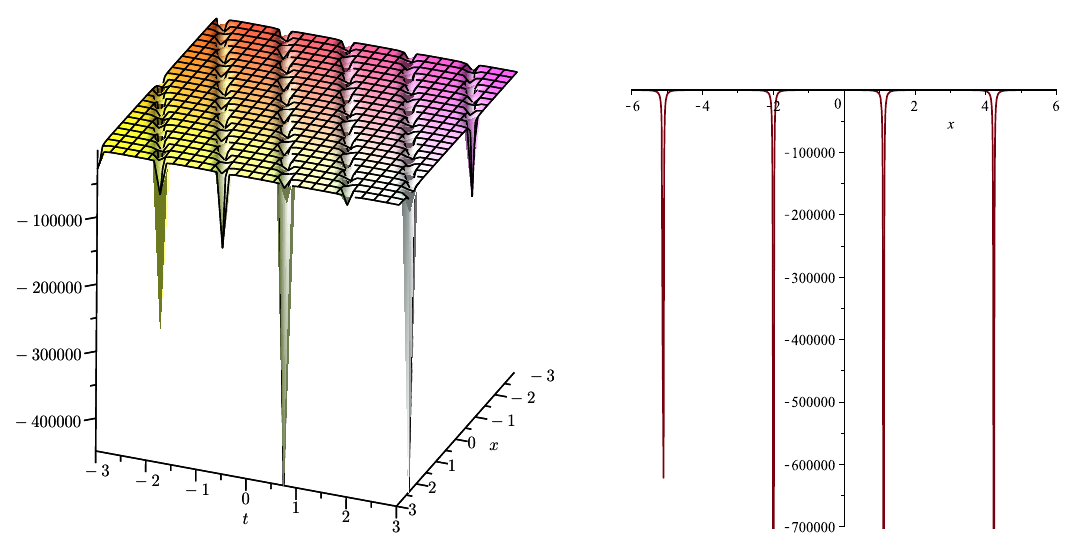
x , t 3 3. ( right ) 2D − ≤ ≤